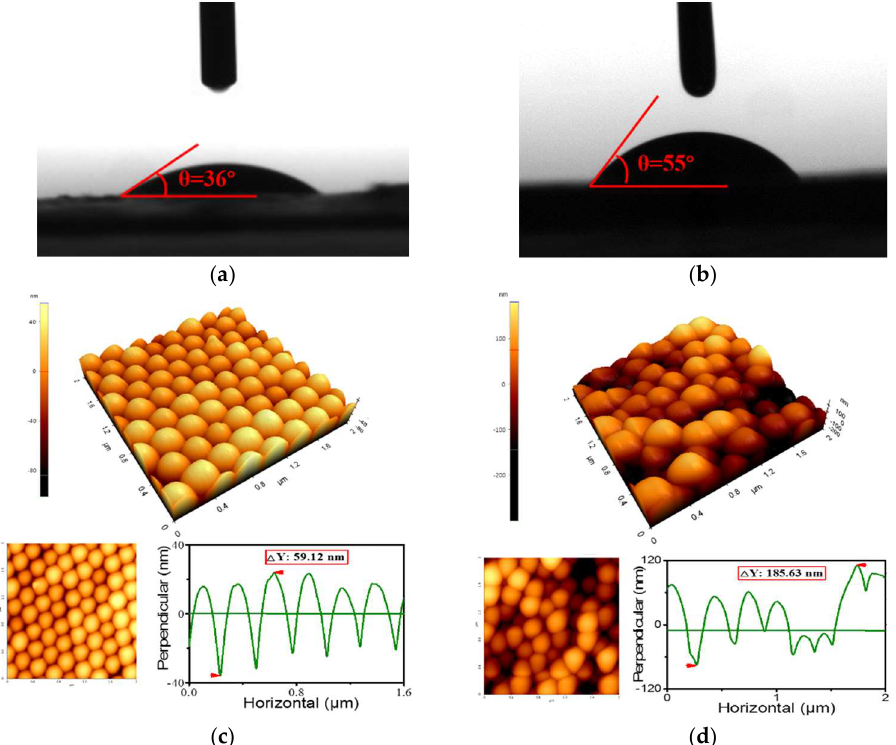
Figure 7. Water CA on SiO 2 PCs ( a ) and SiO 2 APSs ( b ); AFM morphology of SiO 2 PCs ( c ) and SiO 2 APSs ( d ) .